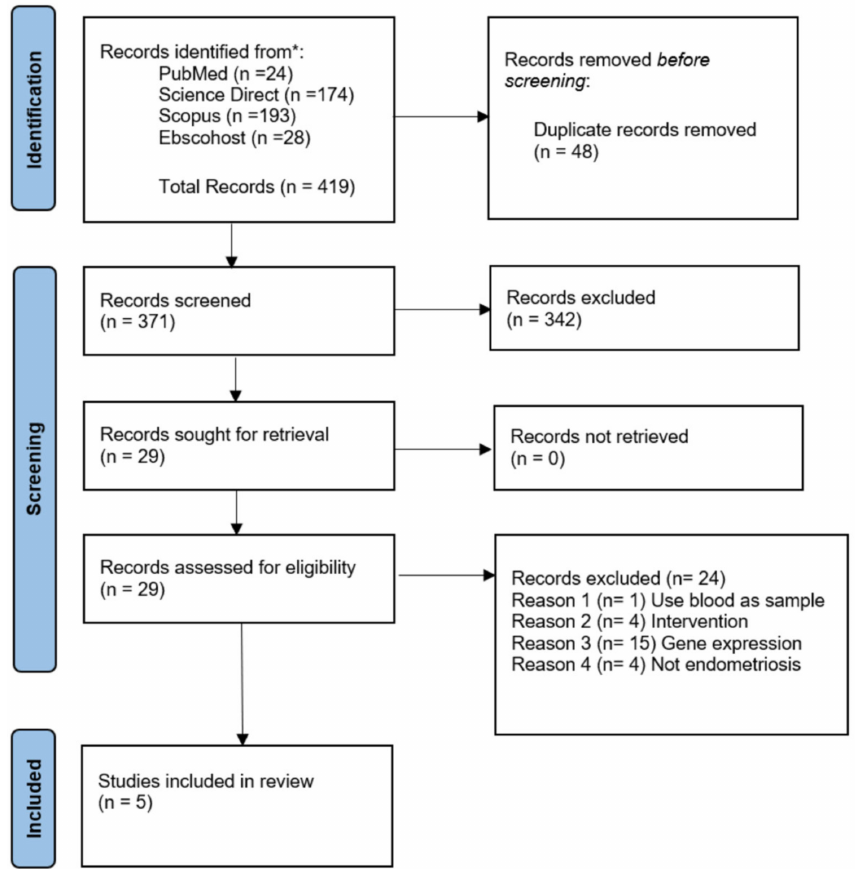
Figure 1. PRISMA flow diagram for studies selection in this systematic